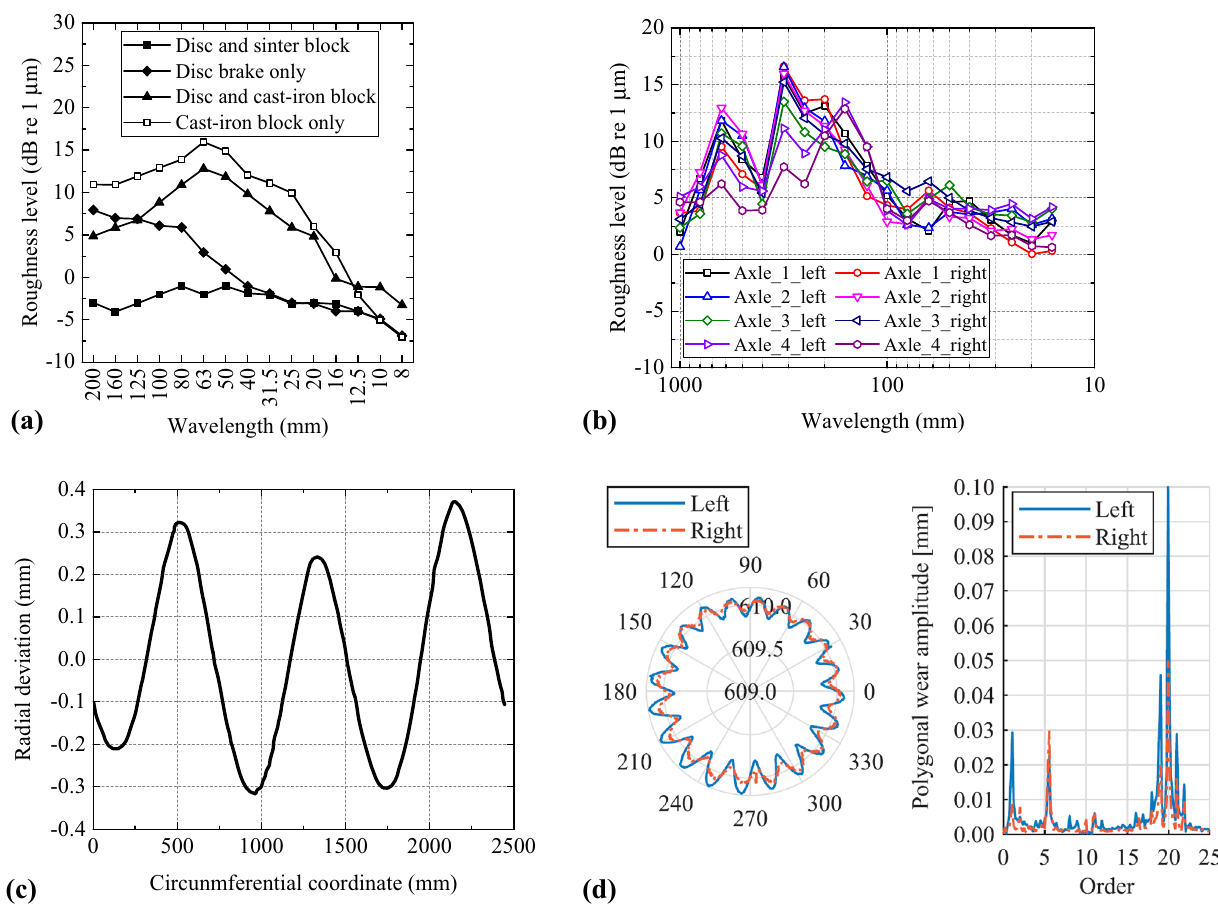
Fig. 1 a Wheel corrugation with wavelengths of 50–70 mm measured in the Dutch railway [9] described in 1/3-octave bands; b wheel polygonisation with dominant wavelengths of 315 mm and 630 mm of TRAXX locomotive wheels measured in Switzerland [11] and described in 1/3-octave bands; c wheel polygonisation with three harmonics of metro train wheels measured in Sweden [5] and described in the Cartesian coordinate system; and d wheel polygonisation with 20 harmonics of locomotive wheels measured in South Africa [12] and described in both polar coordinates and special spectrum